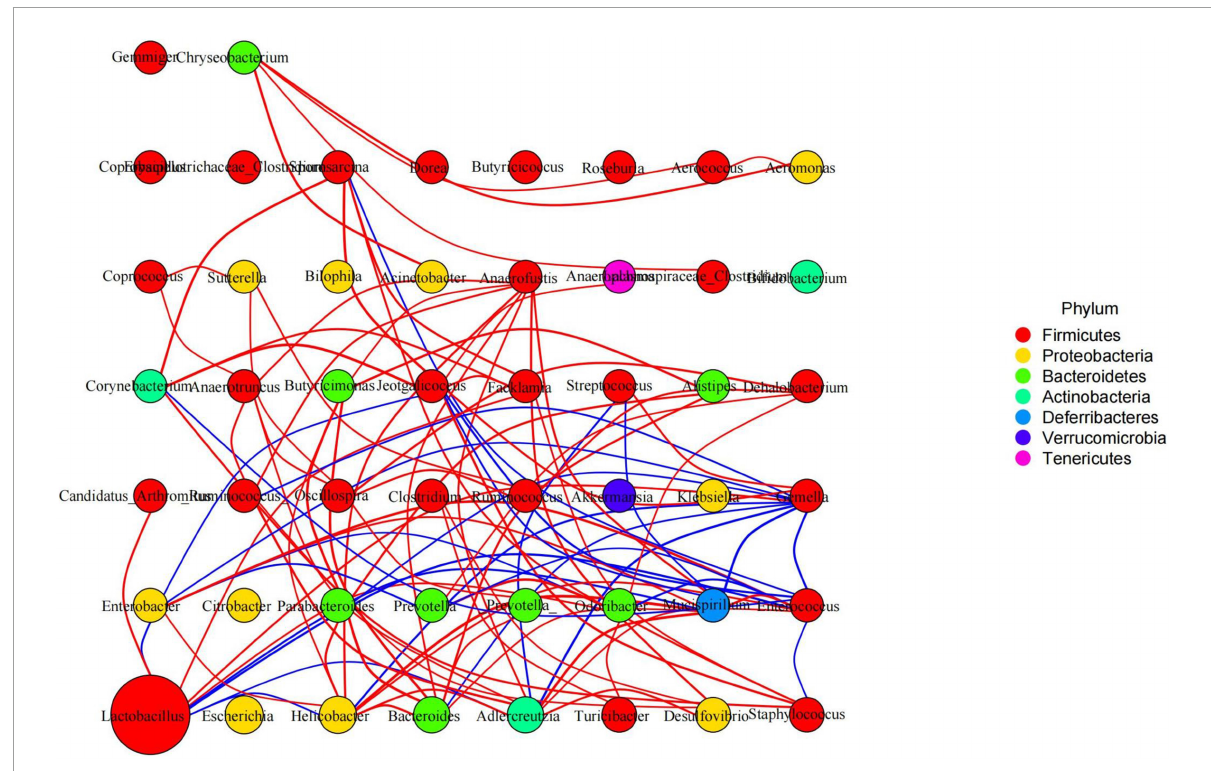
FIGURE11 Species interaction network diagram of mice gut microbiota at the genus level. Red represents a positive correlation, blue represents a negative correlation.